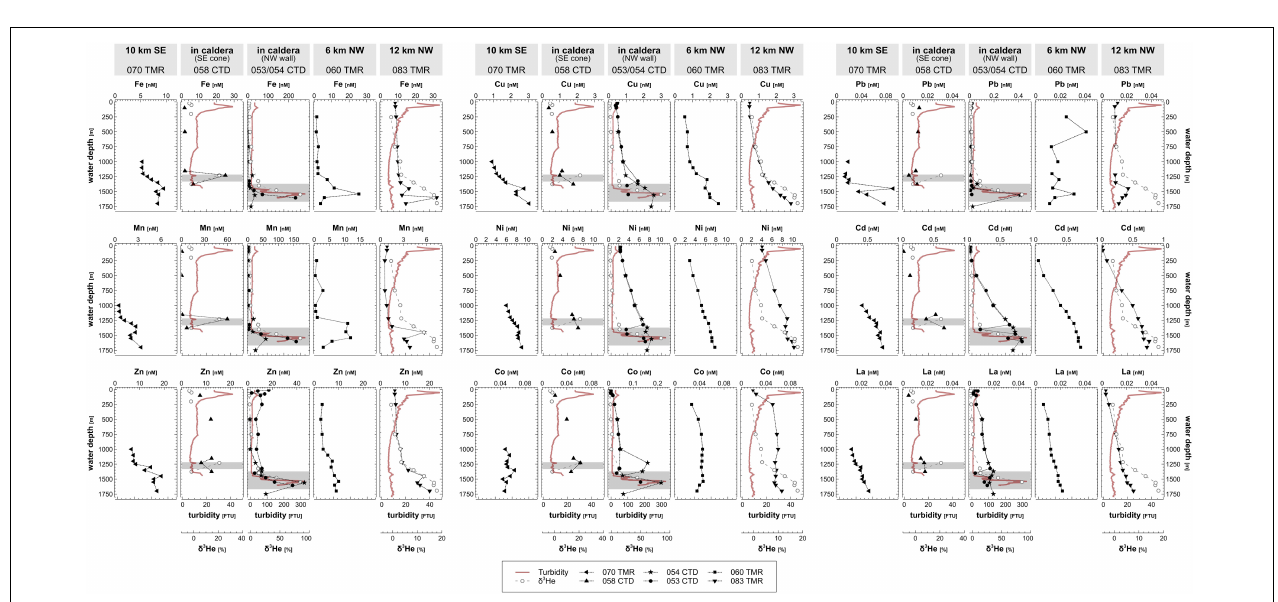
FIGURE 8 | Dissolved metal concentrations of Fe, Mn, Zn, Cu, Ni, Co, Pb, Cd, and La for six different CTD casts over the Brothers volcano, together with δ 3 He and turbidity data. No δ 3 He and turbidity data are available for TMR 070 and TMR 060. δ 3 He and turbidity data for TMR 083 was taken from CTD 082, which was conducted at the same location and same day. The gray areas in the plots of the CTDs taken within the caldera indicate depths of the hydrothermal vent sources (Kleint et al., 2019).